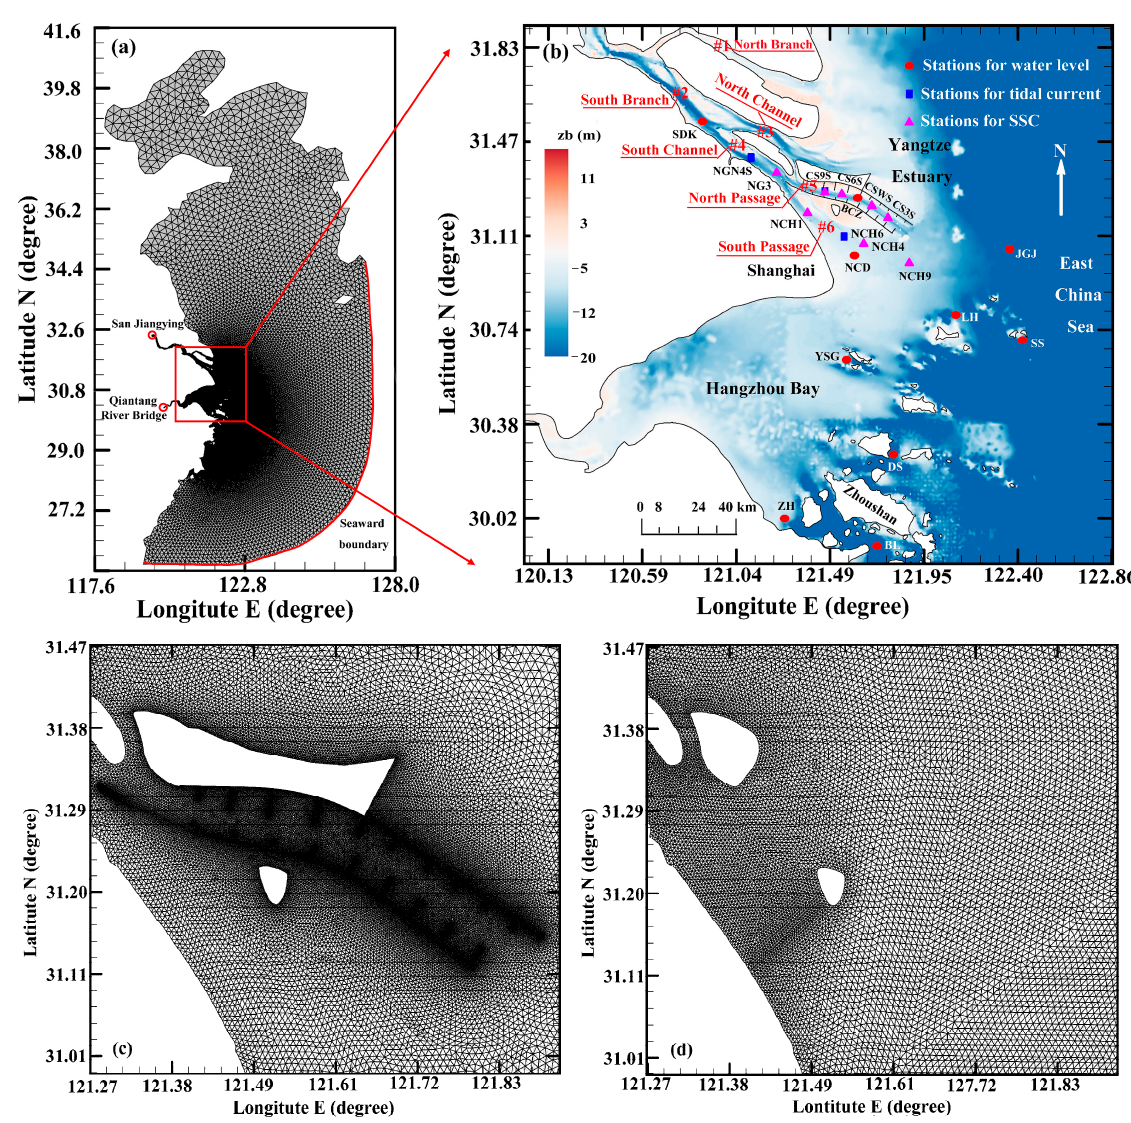
Figure 3. ( a ) Model domain embedded with a set of meshes; ( b ) part of the bed topography. Also included in Figure 3b are stations for the available measured data; ( c ) local meshes considering the DNC engineering; ( d ) local meshes without considering the DNC engineering.